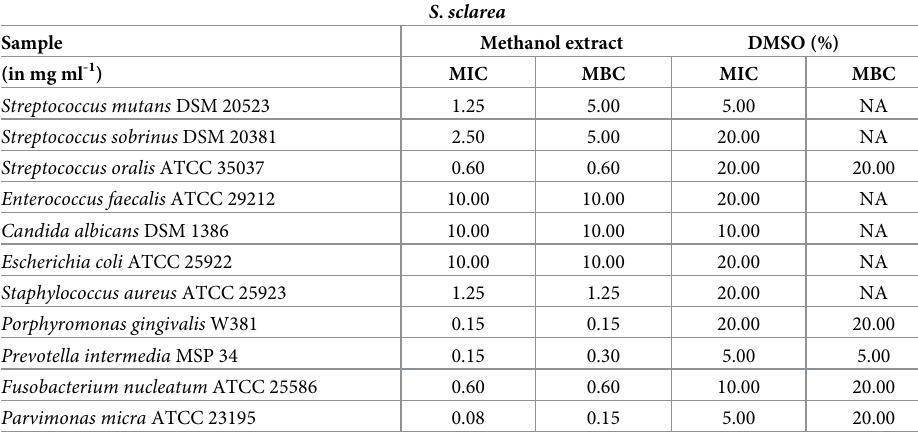
Table 10. Antimicrobial activity in mg ml -1 of S . sclarea methanol extract.